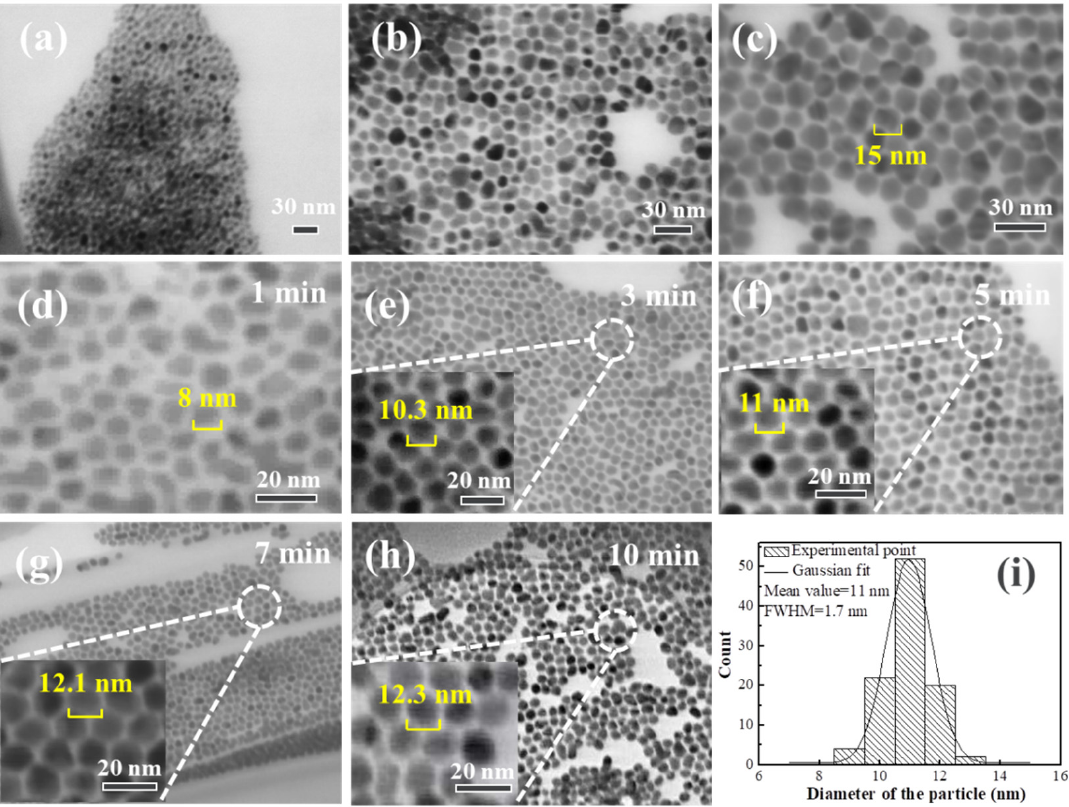
Figure 1. TEM images of the injection temperature at 110 ◦ C ( a ), 120 ◦ C ( b ), and 130 ◦ C ( c ) for 10 min, respectively. Scale bar, 30 nm; TEM images of as-prepared HgTe CQDs sampled under 120 ◦ C at 1 min ( d ), 3 min ( e ), 5 min ( f ), 7 min ( g ), 10 min ( h ) growth time, scale bar, 20 nm; ( i ) Histogram of diameters for 100